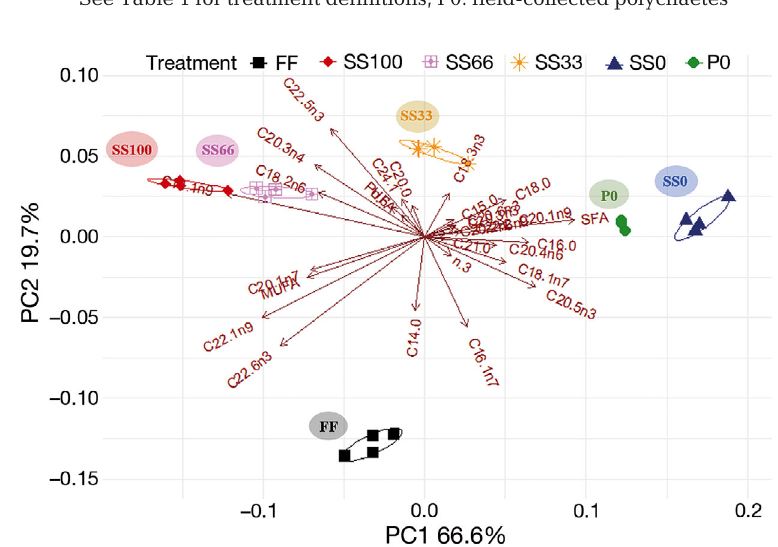
Fig. 5. PCA of fatty acids (% of total fatty acids) of Hediste diversicolor fed dif- ferent feeds; data were arcsine transformed. Saturated, monounsaturated, polyunsaturated and total fatty acids were included. See Fig. 1 for treatment definitions; P0: field-collected